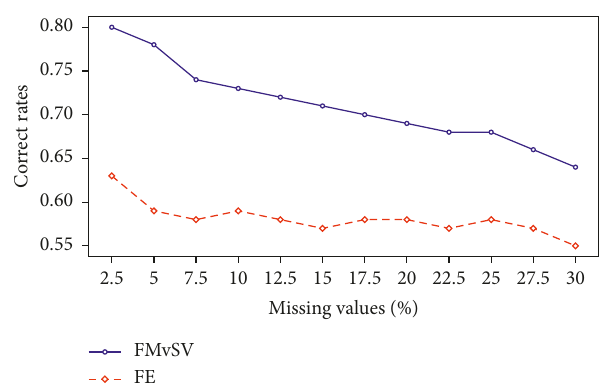
Figure 3: Comparison of correct rates of Algorithm FMvSV and Algorithm FE.